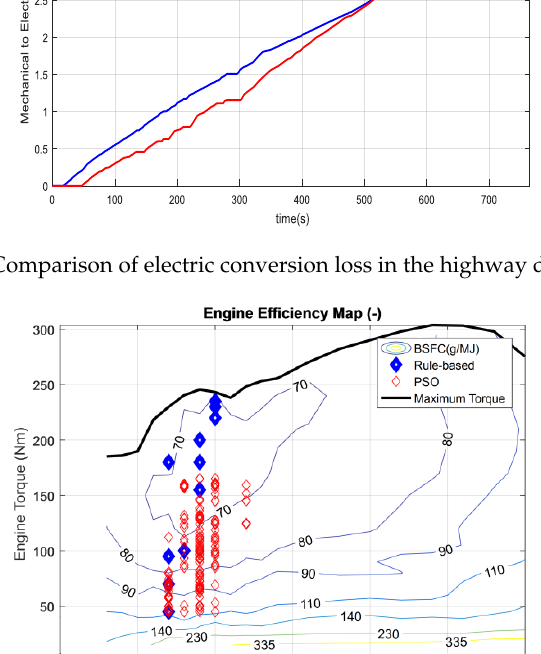
Figure 18. Comparison of urban engine operating points. Energies 2019 , 12 , x FOR PEER REVIEW